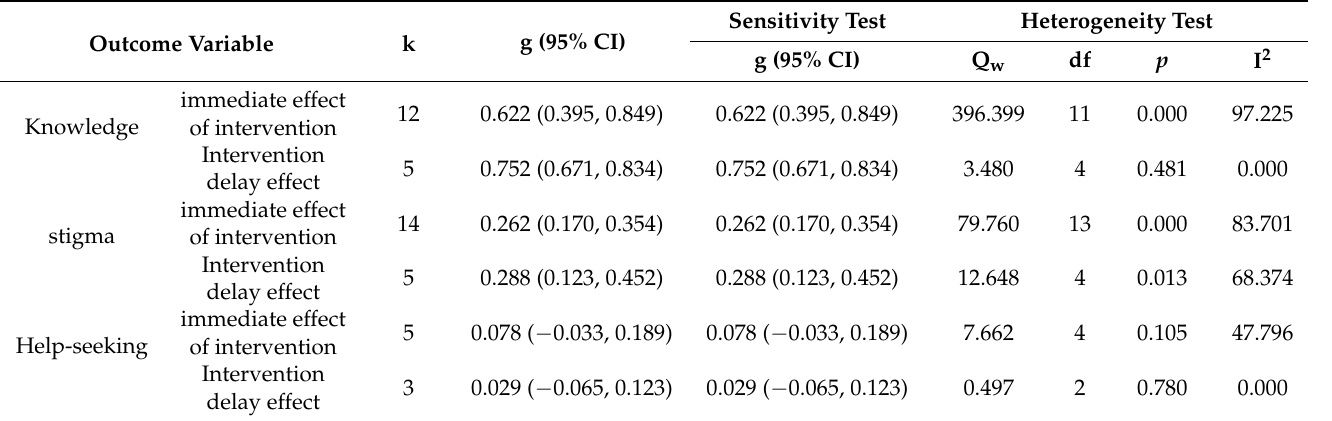
Table 3. Main effects and sensitivity